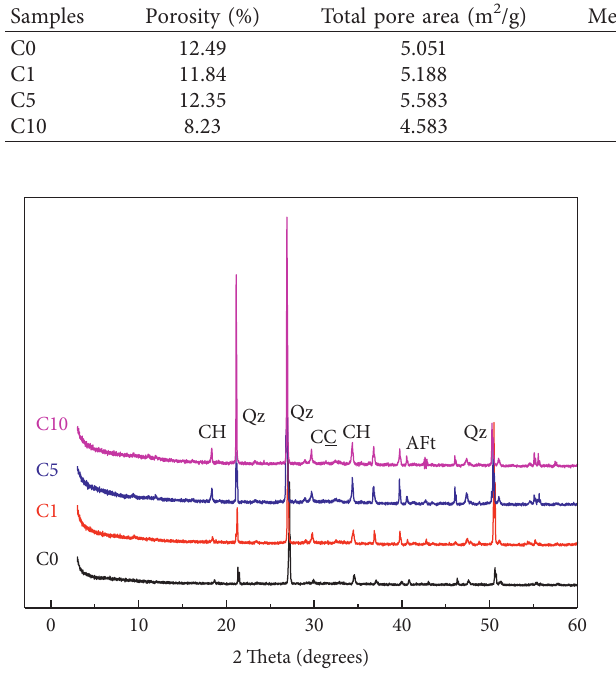
Figure 8: The XRD patterns of CNT-mortar samples with the various dosage of CNT-COOH after 28 days of curing